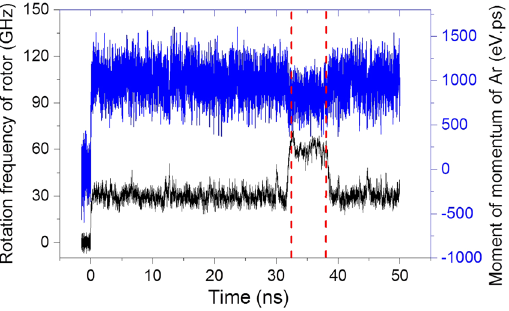
Figure 6. Histories of the rotational frequency of the rotor and the moment of momentum of argon in the system with the N = 7 nanomotor at 100 K. The initial argon density is 120 kg/m 3 .